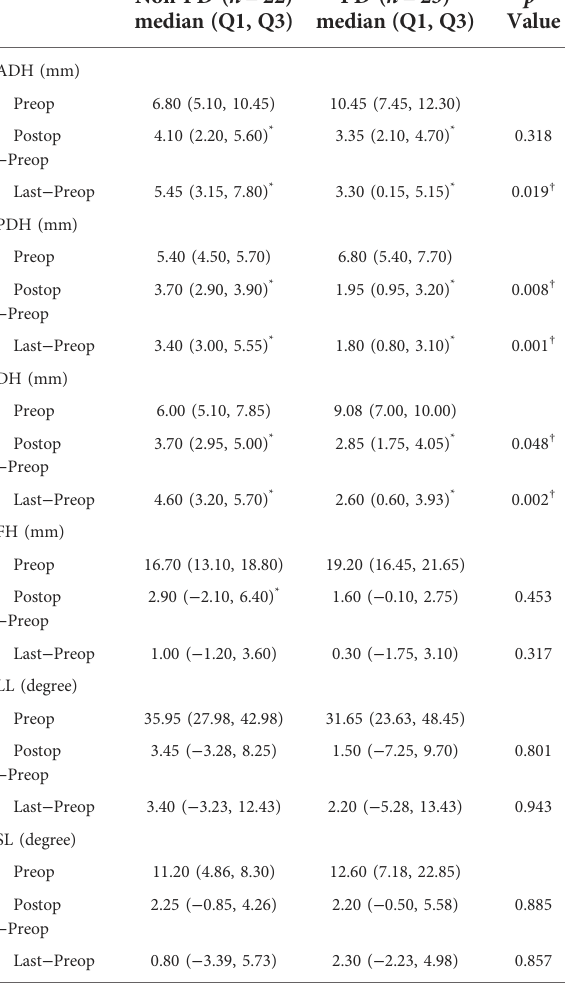
TABLE 3 Comparison of the radiologic outcomes between the Non- PD and the PD groups.